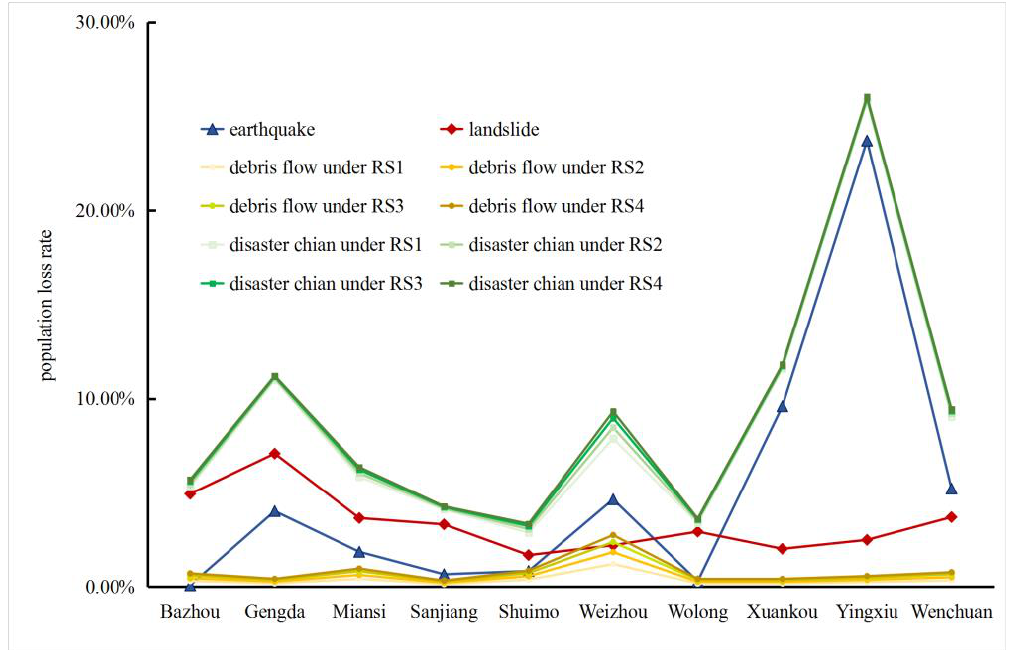
Figure 7. Comparison of the population loss rate caused by an earthquake-landslide-debris flow disaster chain in the different townships. Table 4. Population loss risks and rates caused by a disaster chain under different earthquake intensities. Earthquake Intensity VIII IX X XI Population